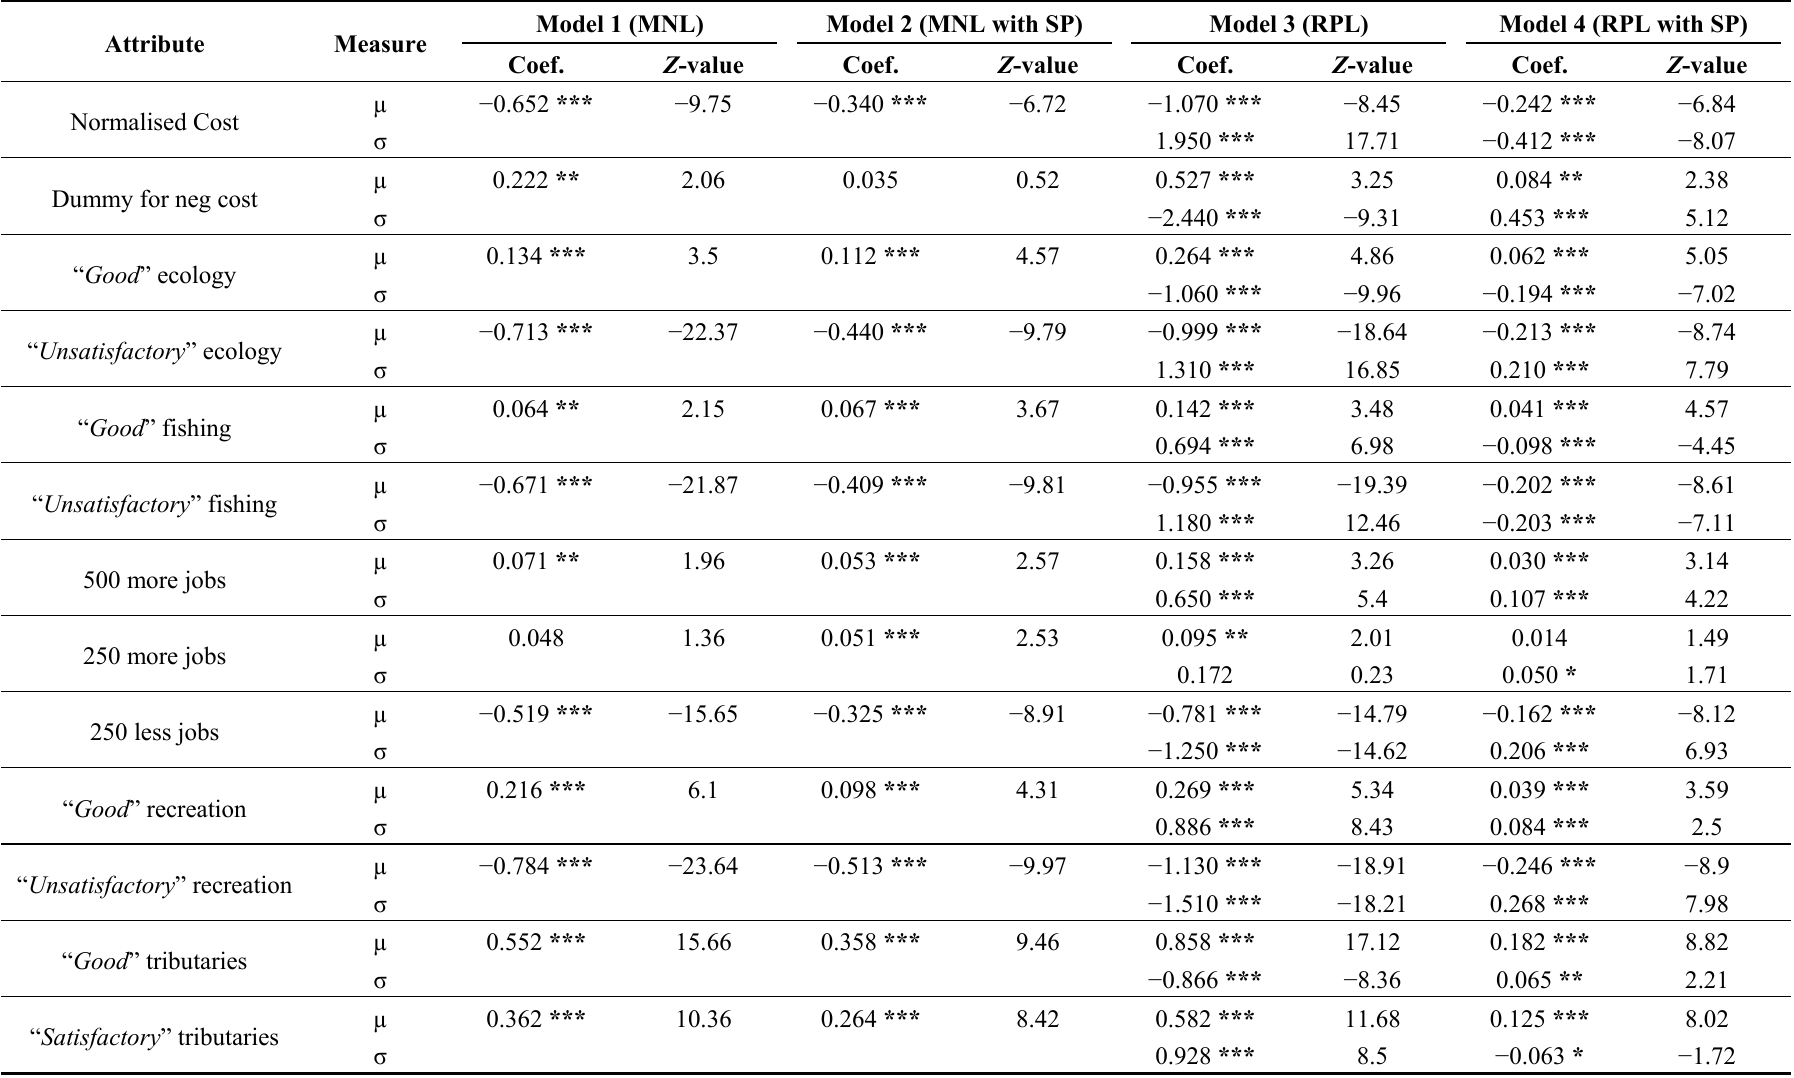
Table 4. Results—Attribute coefficients and model